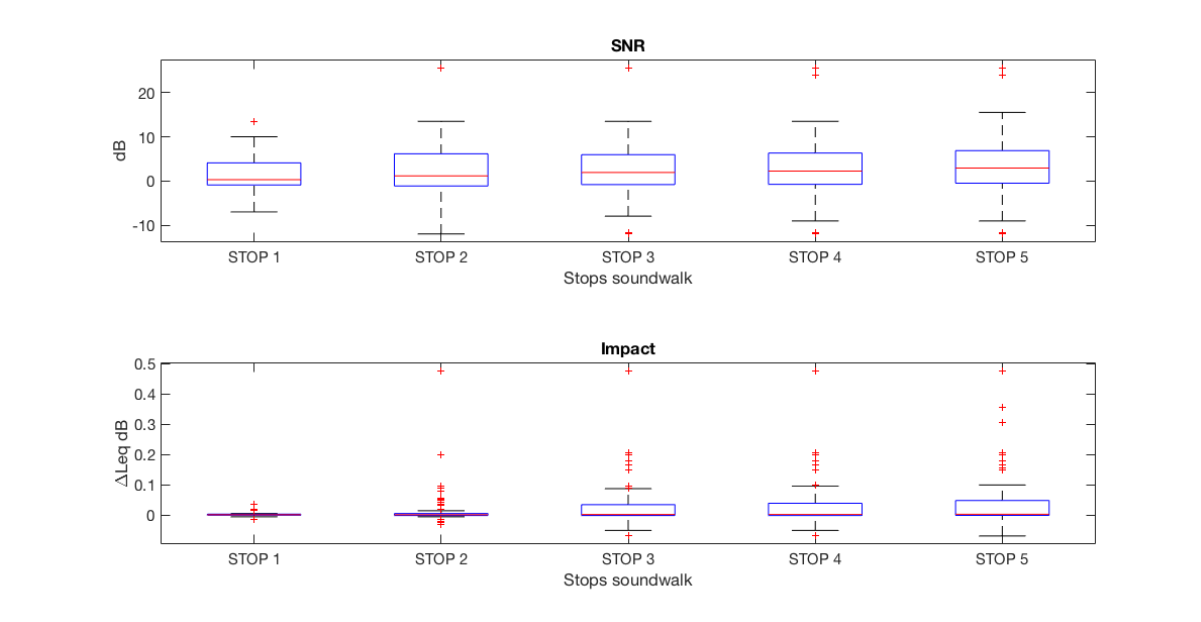
Figure 3: SNR and Impact of all the labelled events in the Poblenou Superblock soundwalk. Stop 1 presents 76 events, Stop 2 presents 75 events, Stop 3 presents 27 events, Stop 4 presents 14 events and Stop 5 presents 26